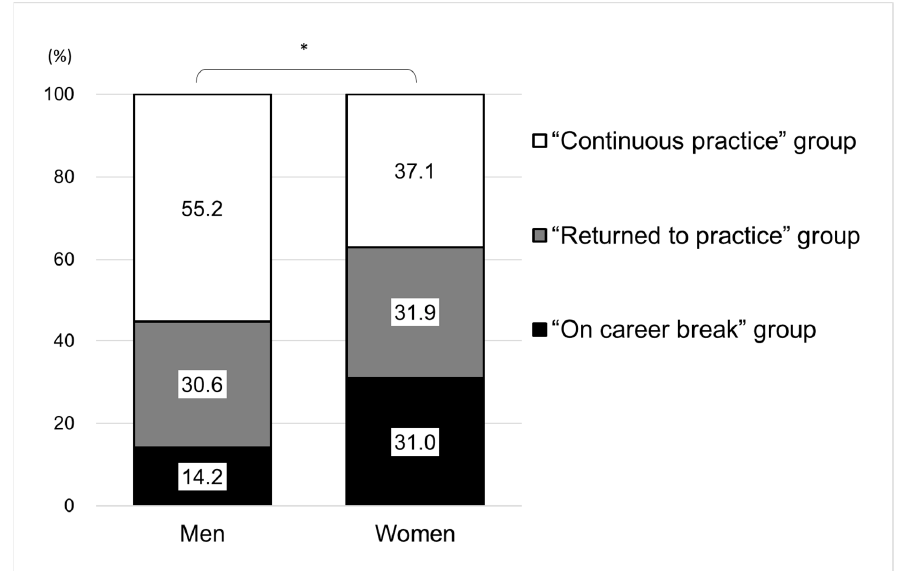
Figure 3. Proportion of three categories by gender (men: 1680, women: 984). “Continuous practice” group: those who were working continuously between 2006 and 2016, “Returned to practice” group: